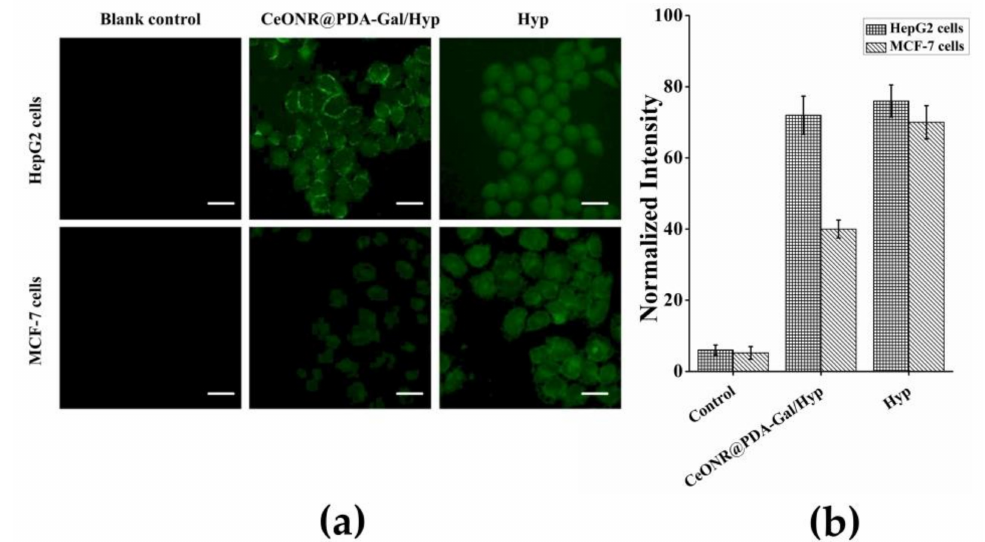
Figure 5. ( a ) The fluorescence intensity of DCF in HepG2 cells and MCF-7 cells was observed by fluorescence microscopy. Scale bar: 20 µ m. ( b ) Quantitative analysis of the fluorescence intensity of DCF in HepG2 cells and MCF-7 cells by Image-Pro Plus (n =